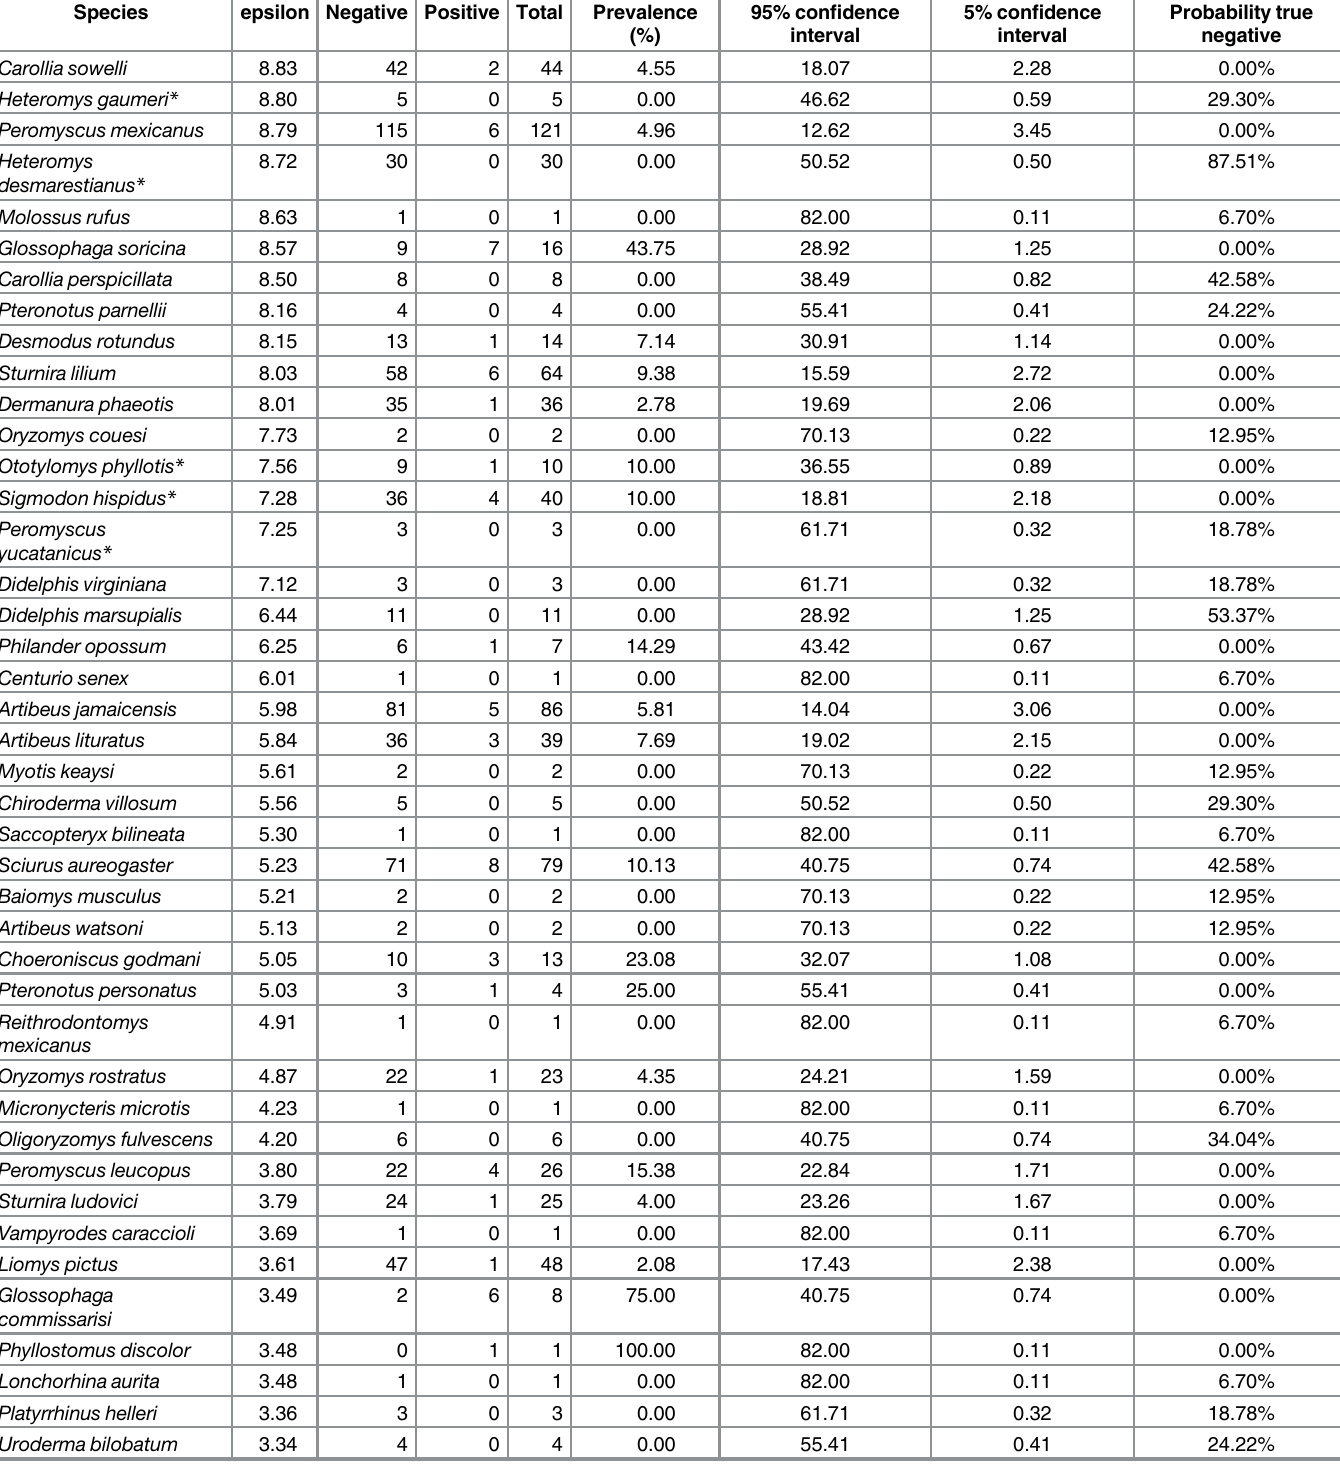
Table 1. List of collected species, ranked by ε (see Eq 1 of Methods), with the number of individuals that tested positive for the presence of the par- asite Leishmania ( L .) mexicana and the number that tested negative.